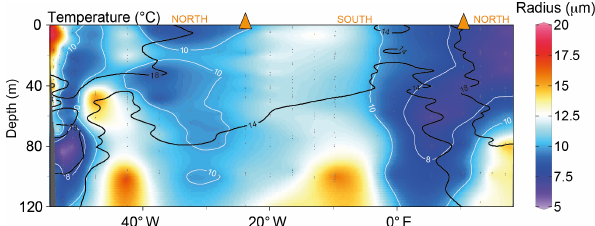
Figure 5. The estimated average phytoplankton community cell ra- dius. The average radius (white contour lines) was calculated us- ing the proportions of pico-, nano- and microplankton in Fig. 4. We estimate the average radius using assumed cellular radii of 0.5, 2.5 and 25µm for pico-, nano- and microplankton, respectively. The black contour lines show the 14 and 18 ◦ C isotherms. The interpolation was produced using ODV-weighted average gridding (Schlitzer,